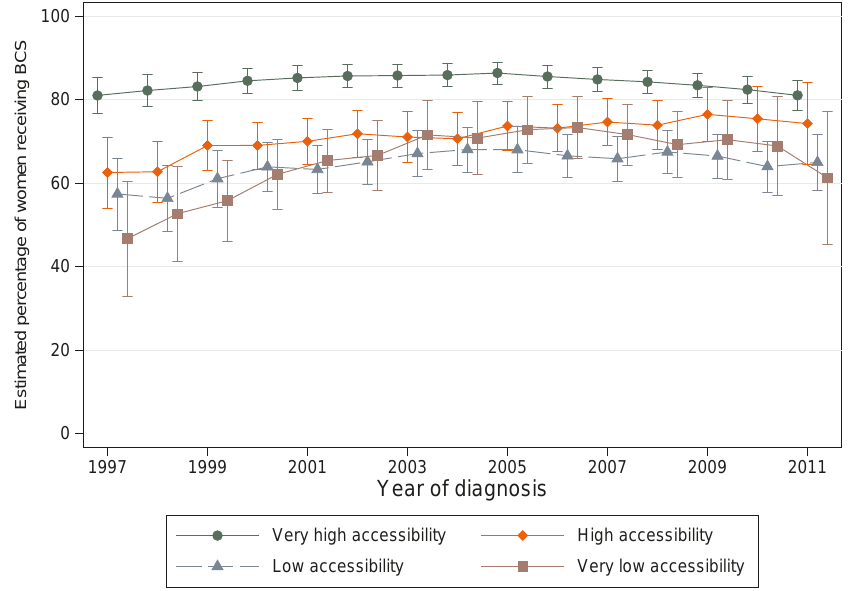
Figure 1. Estimated number of women with localised breast cancer out of 100 (percentage) undergoing breast conserving surgery (BCS) by accessibility and year of diagnosis, Queensland 1997–2011.